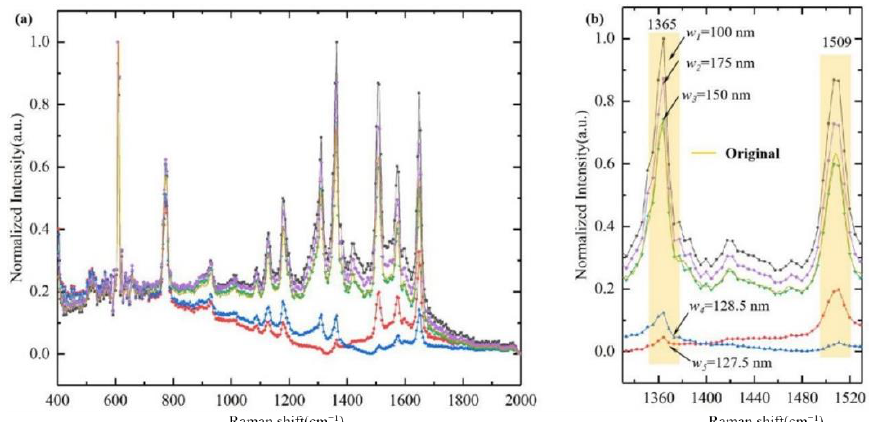
Figure 7. ( a ) The original Raman intensity (yellow) and reconstructed information when the gold nanowires width is 100 nm (black), 127.5 nm (red), 128.5 nm (blue), 150 nm (green) and 175 nm (purple); ( b ) enlarged information at typical characteristic peaks of 1365 cm − 1 and 1509 cm − 1 . The results also show that when the gold nanowires width is 100, 150 and 175 nm, the corresponding position error at the Raman peak of 1365 cm − 1 and 1509 cm − 1 is 0.774 cm −1 and 2.574 cm − 1 , respectively. The corresponding normalized intensity errors of the reconstructed spectrum are 37.17%, 1.92% and 19.62% at 1365 cm − 1 , 37.07%, 5.52% and 14.04% at 1509 cm − 1 , respectively. Taking into consideration the current processing tech- nologies, the gold nanowire width of 150 nm could be more cost-effective.